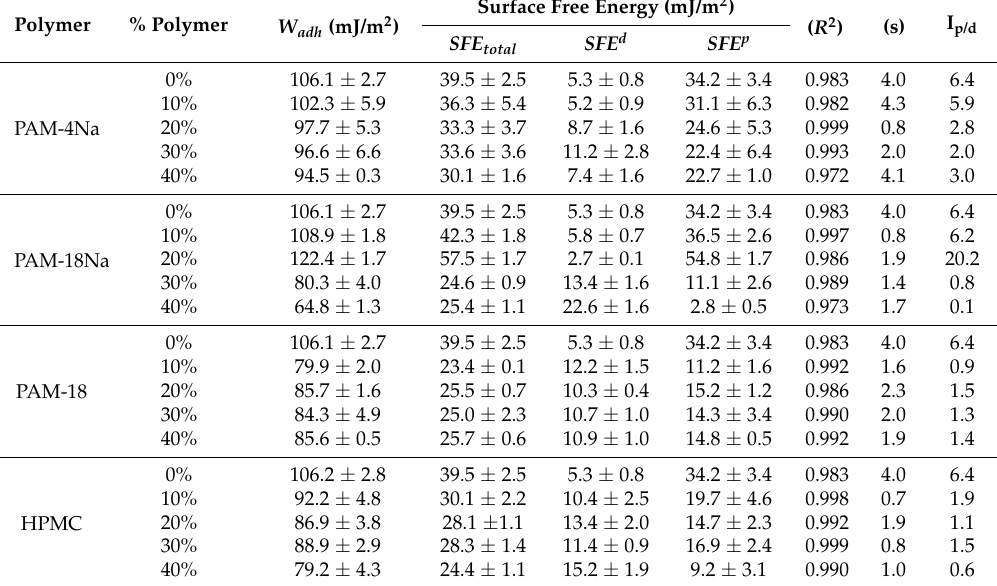
Table 4. Values of W adh and SFE total for ampicillin trihydrate tablets alone and with polymeric materials at different